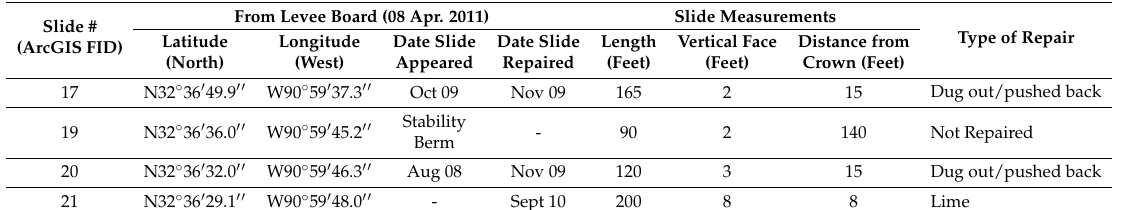
Table 2. Levee slides’ ground truth data from the Mississippi Levee Board.